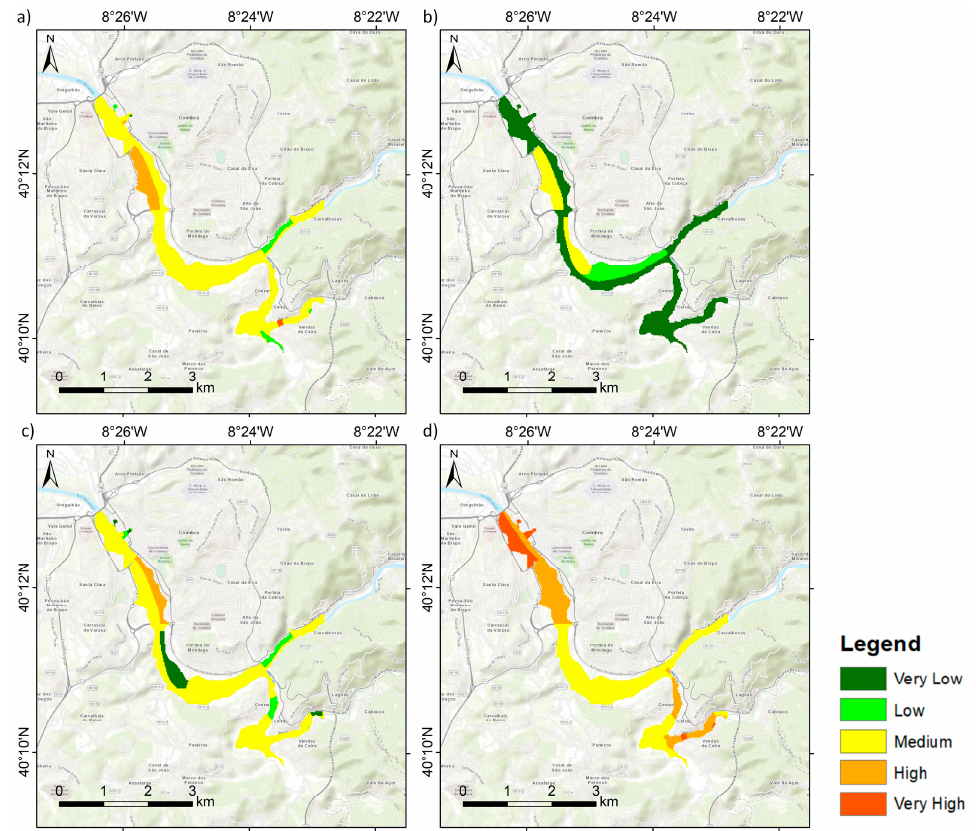
Figure 9. Detailed criteria map for the flood-prone area of Coimbra (Mondego River): ( a ) Population criterion of flood vulnerability; ( b ) Socio-economic criterion of flood vulnerability; ( c ) Buildings criterion of flood vulnerability; ( d ) Exposed elements criterion of flood vulnerability.